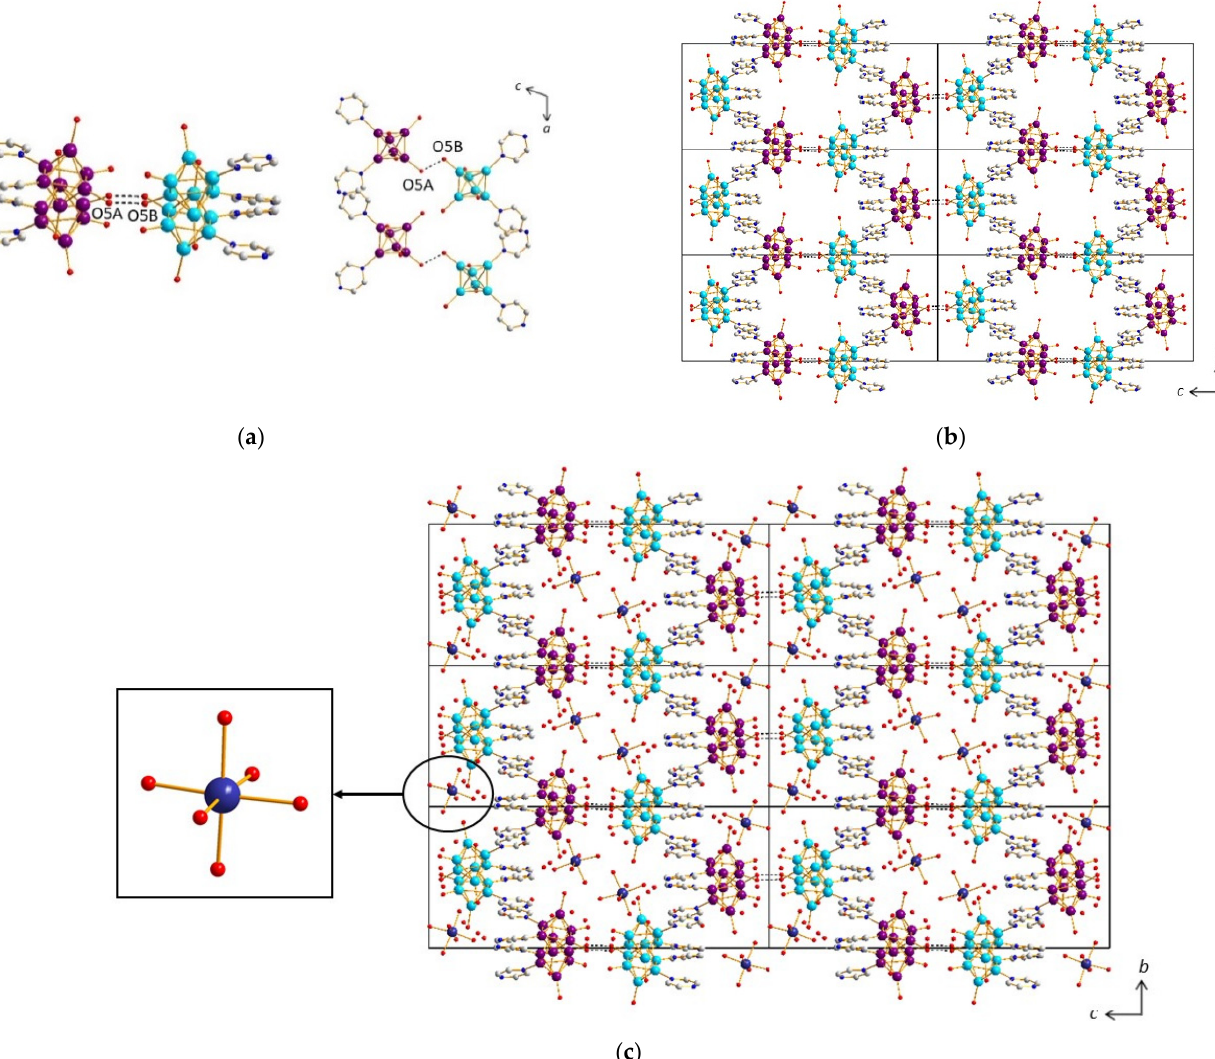
Figure 9. ( a ) H 3 O 2 − bridges in the structure of ( 4 ) promoting the formation of cluster dimmers. ( b ) Stacking of the layers yielding to the three-dimensional supramolecular framework of ( 4 ). ( c ) View of the structure of ( 4 ) along the a axis showing insertion of Mg(H 2 O) 6 octahedra into the voids of the supramolecular framework.